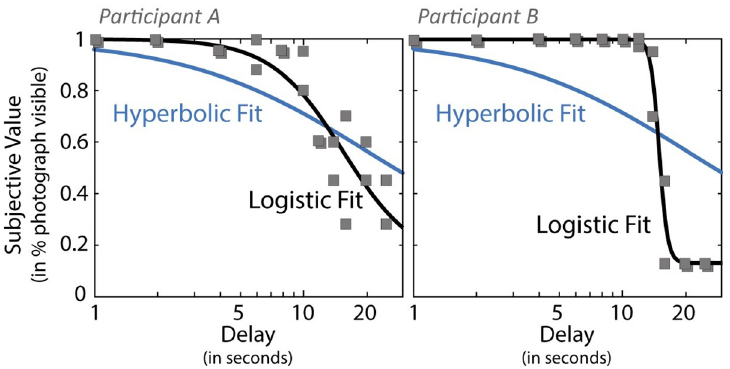
Fig 5. Fitting indifference point data. Example of indifference points obtained for two participants during the experiential intertemporal choice task (squared markers), and comparison of fit using a logistic function (black solid line) and a hyperbolic function (blue solid line). Delay is presented using a logarithmic scale. https://doi.org/10.1371/journal.pone.0251480.g005 participant (left panel), and regression lines for all participants (right panel). Linear mixed modeling revealed a negative fixed effect of occlusion on pleasantness ratings ( β = -0.55, t (44 . 1) = 18.1, p < .001). The fit of the model with occlusion levels as fixed and random effects ( AIC = 9434, BIC = 9469, R 2 = 0.84) was better than that of the null model ( AIC = 11649, BIC = 11667, R 2 = 0.19), and the difference in model fits was significant ( χ 2 (3) = 2221, p < .001). Pearson’s product moment correlations calculated separately for each participant aver- aged r = -0.73 ( SD = 0.16) and were significant ( p < 0.05) for all but one participant. The abso- lute values of the correlations between photograph occlusion and pleasantness ratings were used to model individual differences in reward sensitivity in the path analyses.